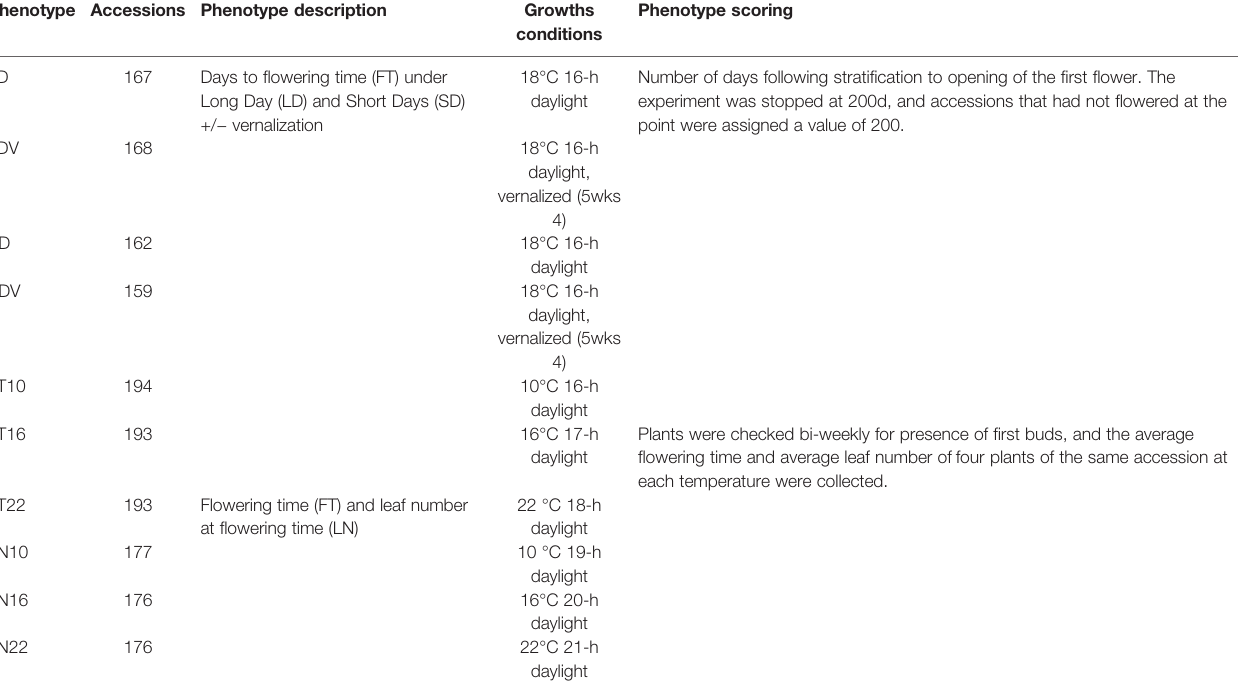
TABLE 1 | Description of the 10 fl owering related phenotypes in A.thaliana in real data